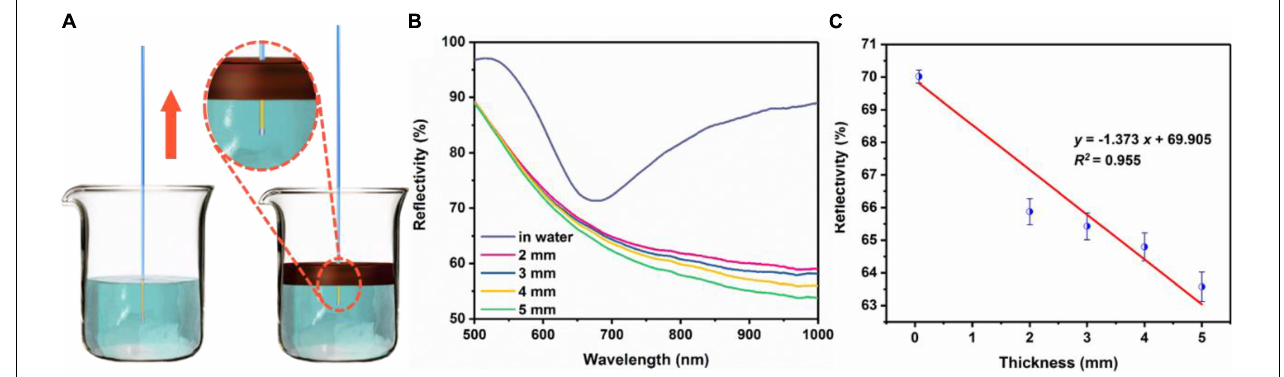
FIGURE 2 | (A) Schematic diagram of oil detection at the water-oil interface by FOSPR sensor (the top of the sensing region is kept on top of the oil); (B) Reflectivity spectra of the electroless-plated optical fiber surface plasmon resonance (SPR) sensors in the water-oil interface with different oil spill thicknesses; and (C) Linear curve of reflectivity and oil slick thickness (the linear relationship is based on a wavelength of 682.91 nm).